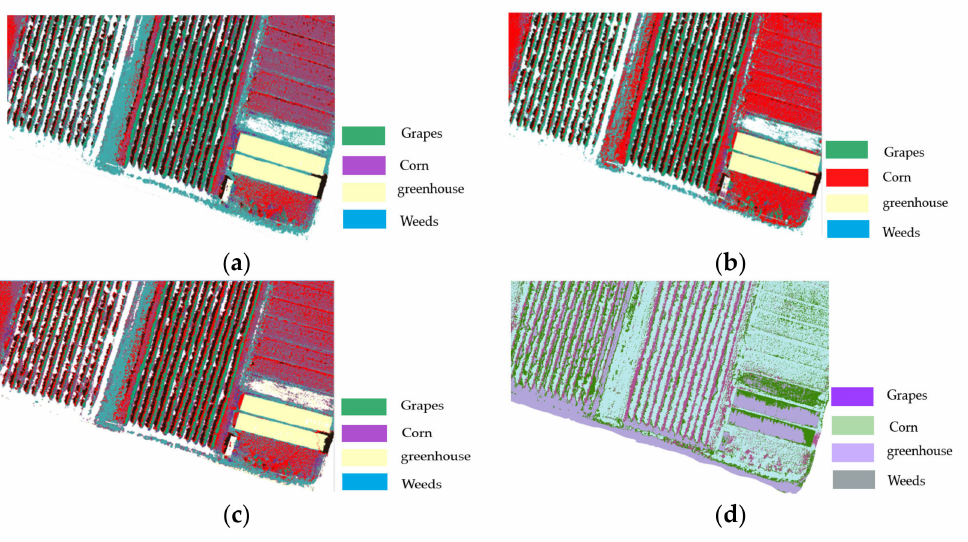
Figure 8. Classification effects of field grapes under the four methods. ( a ) SVM classification effect.